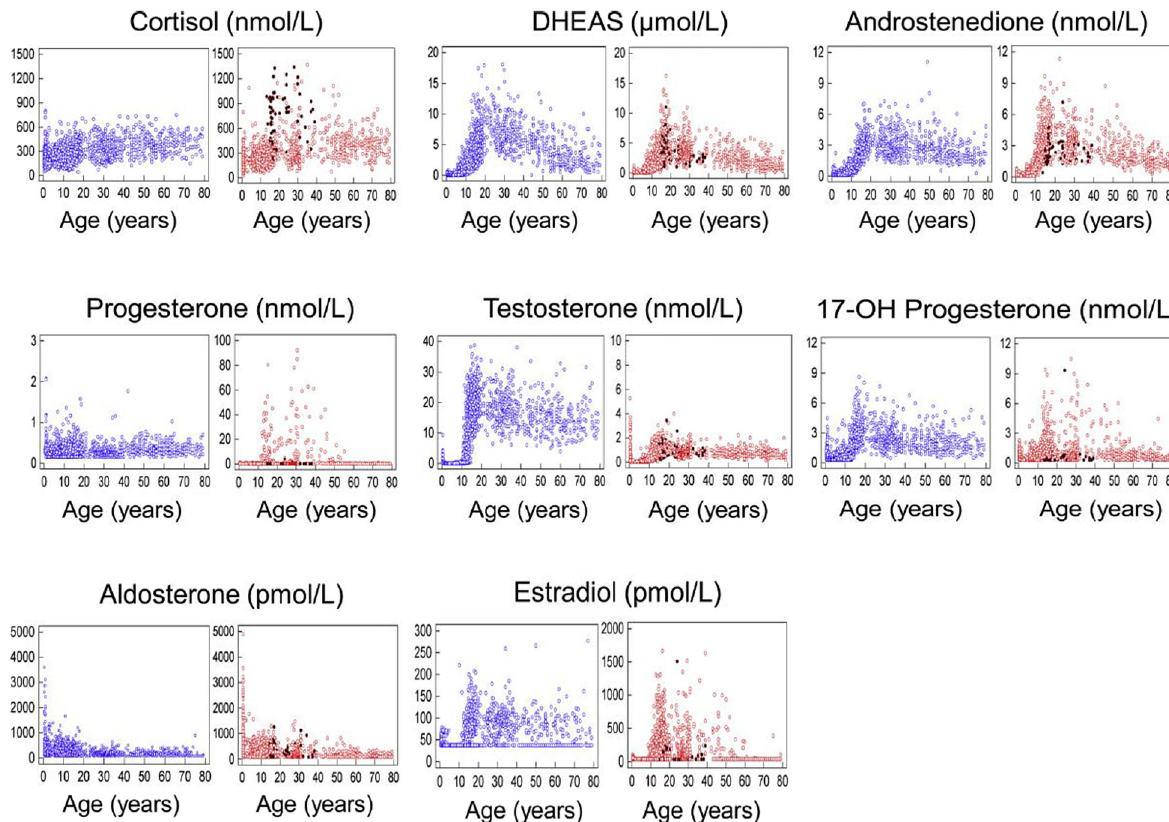
Figure 5: Steroid hormone levels change throughout the lifespan in males and females. Blue: males; red: females without oral contraceptives (oC); black: females with oC. With permission from ref.